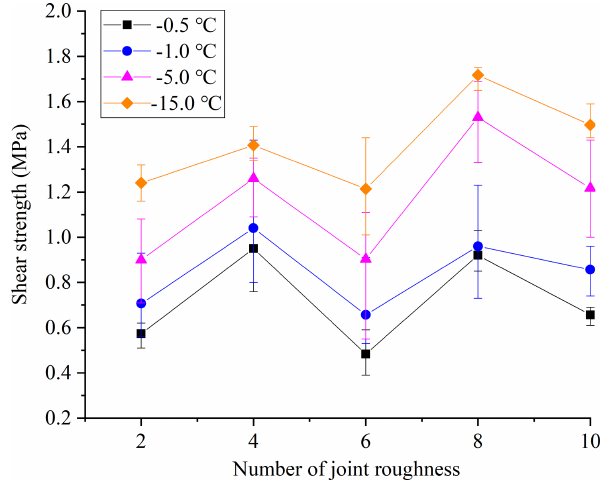
Figure 5. Shear strength against joint roughness at different freez- ing temperatures. Experimental conditions: v = 0.2mmmin − 1 , d = 2mm and σ n = 0.5MPa.